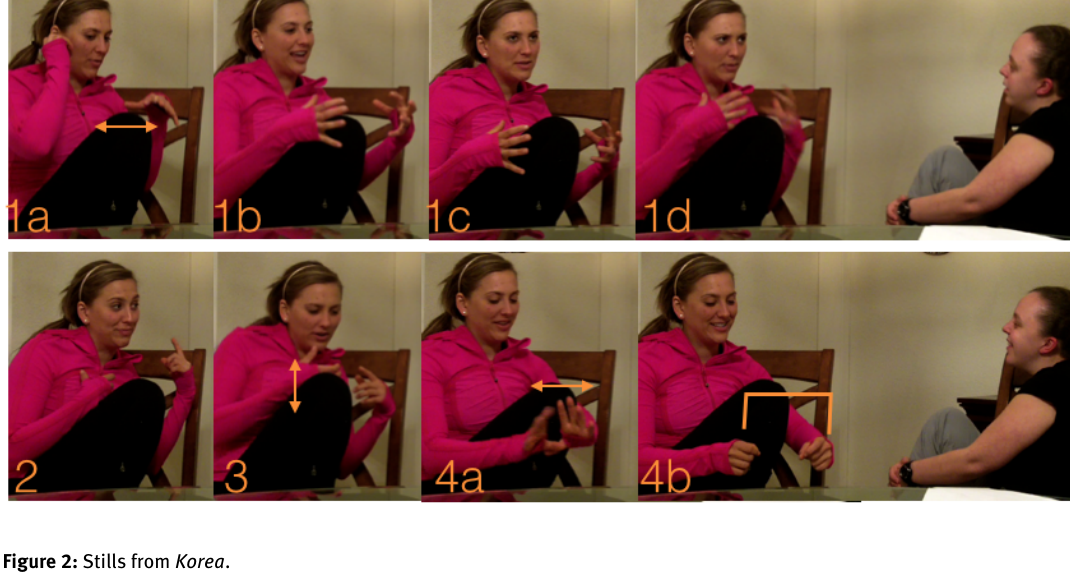
Figure 2: Stills from Korea